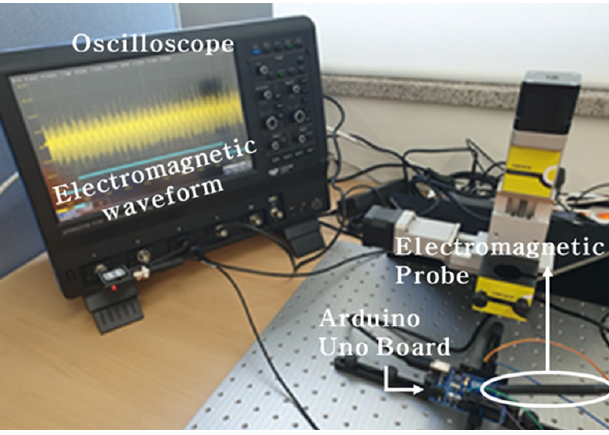
Figure 5. Electromagnetic trace collection environment.